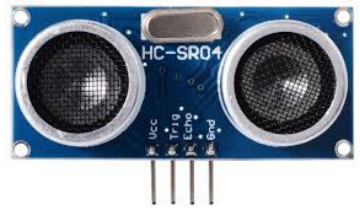
Figure 13. Ultrasonic sensors.